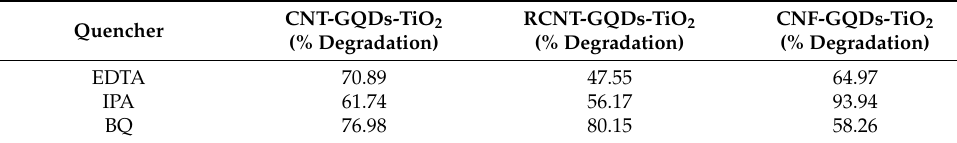
Table 3. Role of quenchers in UV-Vis photocatalysis of MB